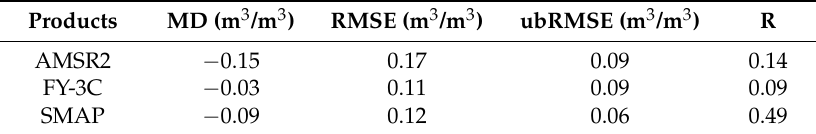
Figure 6. The temporal statistical indices between the satellite soil moisture datasets from FY-3C, AMSR2, and SMAP and the in-situ stations: ( a ) Mean difference (MD), ( b ) root-mean-square error (RMSE), ( c ) unbiased RMSE (ubRMSE), and ( d ) correlation coefficient (R). The median, the 1st quantile Q1, and the 3rd quantile Q3 are indicated by the box, the whiskers represent Q1 − 1.5 (Q3 − Q1) and Q3 + 1.5 (Q3 − Q1) values, and the points represent the outliers. Table 5. The average statistical parameters for FY-3C, AMSR2, and SMAP against the CASMOS measurements of all of the footprints. One hundred and thirteen (113) stations were used for statistics.